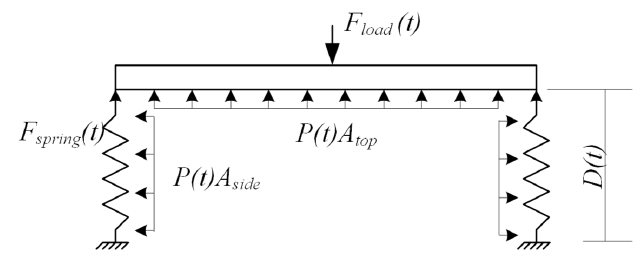
Figure 5. A simplified free-body diagram of the module.